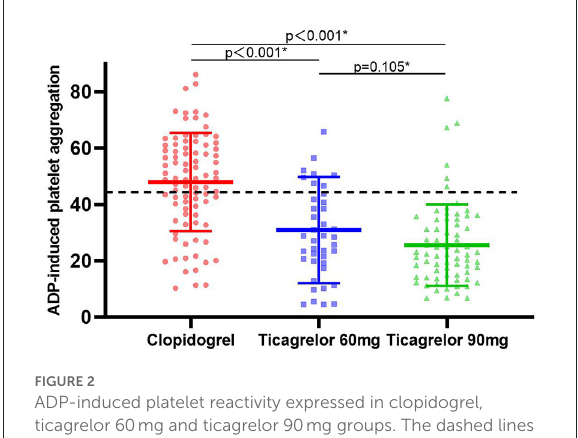
FIGURE2 ADP-induced platelet reactivity expressed in clopidogrel, ticagrelor 60mg and ticagrelor 90mg groups. The dashed lines indicate threshold values for high platelet reactivity. Solid lines with error bars indicate mean ± SD. ADP, adenosine diphosphate. * Adjusted risk factors of age, smoke by linear regression model.